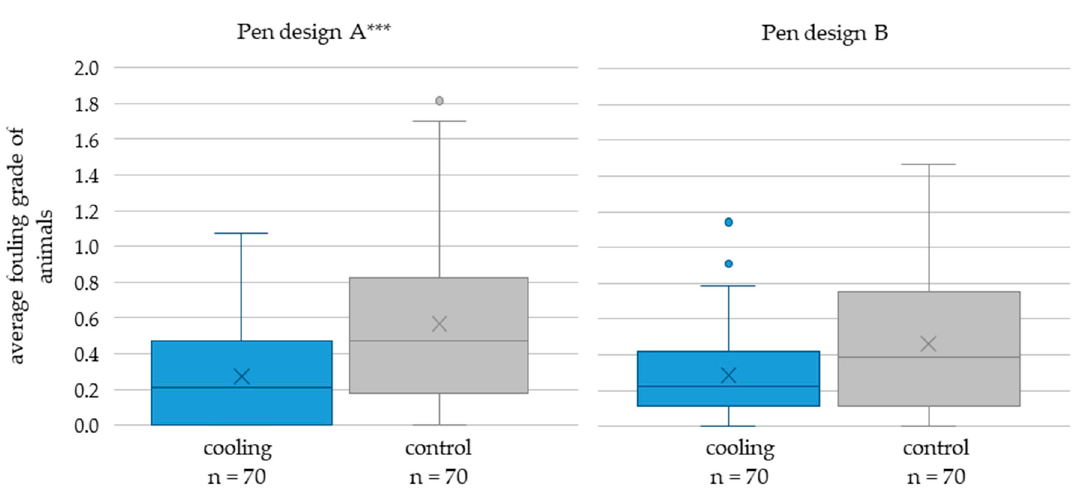
Figure 9. Effect of the floor cooling on the average fouling of the animals for pen design A (0.42 vs. 0.67; SED 0.058 p = 0.0006) and B. (* = significant effect with *** < 0.0001; n = number of observations; usually 12 observations per period and pen, each boxplot contains data of two pens).